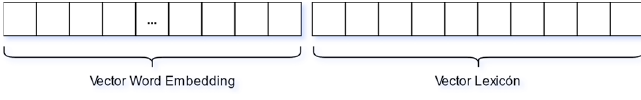
Figure 7. WE_Lexicon feature vector.